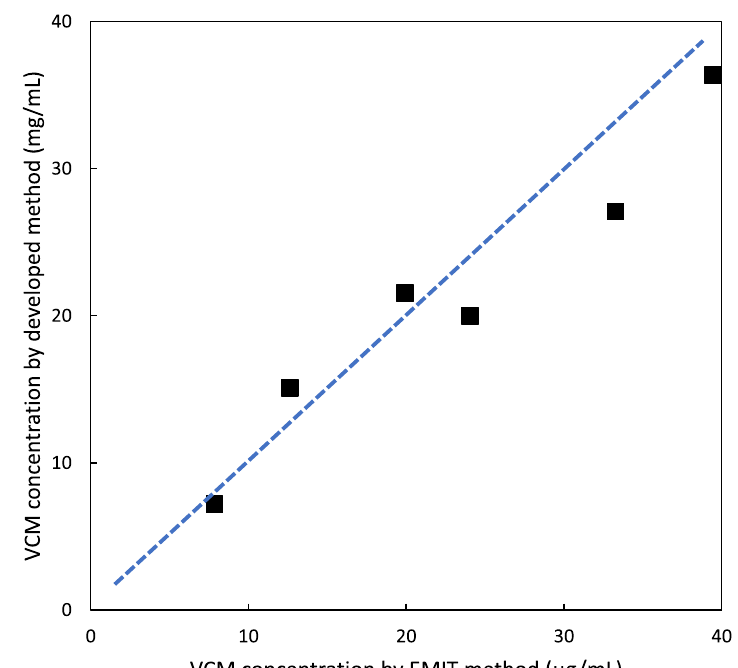
Fig. 5 Comparison of measurement values by the developed method and a clinical laboratory using EMIT method. EMIT method used Emit ®